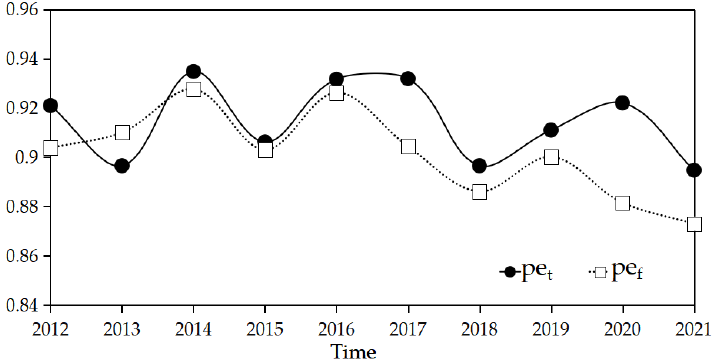
Figure 5. Reciprocals of vegetation and snow cover factors, C t and C f , for the period from 2012 to 2021.